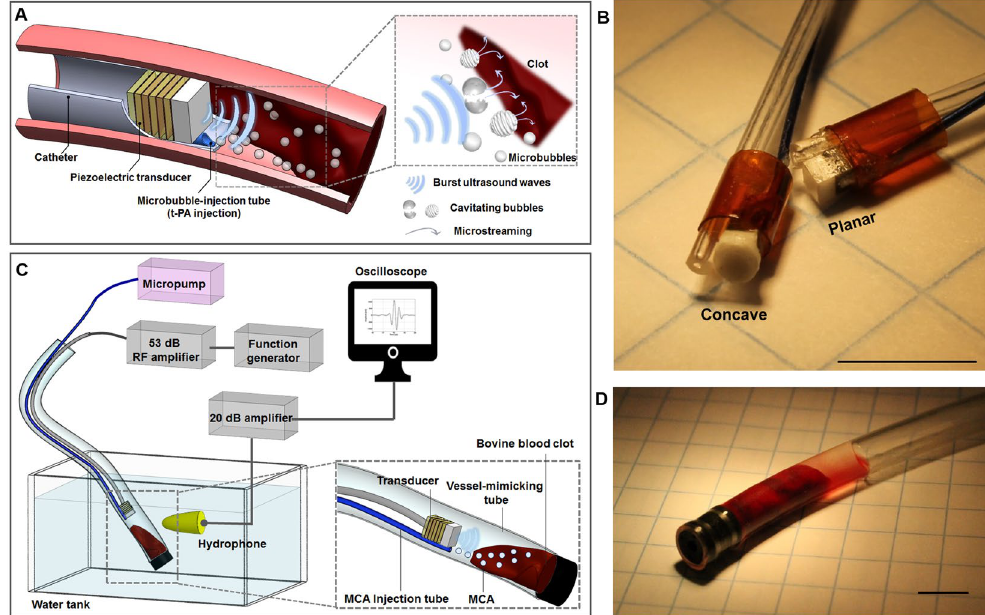
Figure 1. Microbubble-mediated intravascular sonothrombolysis system. ( A ) Principle of microbubble- mediated intravascular sonothrombolysis by using a catheter-tipped forward-looking transducer; low- frequency ultrasound waves generate stable and inertial cavitation of locally injected microbubbles near the target blood clot. ( B ) Customized 620 kHz stacked piezoelectric transducers integrated with a microbubble- injection tube and polyimide housing: concave- and planar-aperture (lateral dimension < 1.5 mm) prototypes (scale bar = 5 mm). ( C ) In vitro experiment setup; a tygon tube (ID: 4 mm, OD: 5.6 mm) was used as a vessel- mimicking structure. The hydrophone was used to detect the microbubble response. ( D ) Bovine blood clot sample (200 mg ± 10%) located in the tygon tube with 50 μ l saline water (scale bar = 5 mm). The figures ( A ) and ( C ) were drawn through the combined use of Solidworks Education Edition, Microsoft PowerPoint, and Adobe Illustrator CC. The figures ( B ) and ( D ) were captured using a digital SLR camera (Canon EOS Rebel T3) with 50 mm lens (Canon, f/2.5 Compact Macro Lens), cropped and aligned using Microsoft PowerPoint and Adobe Illustrator